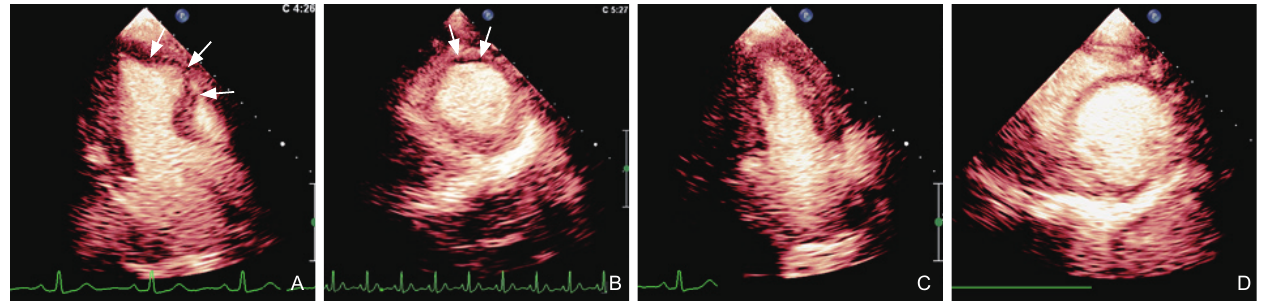
Figure 1 Cardiac catheterography for diagnosis of TTS. (A) Left ventricular angiography showed left ventricular aneurysm (arrow); (B) and (C): Coronary angiography showed no obvious stenosis in left coronary arteries and right coronary